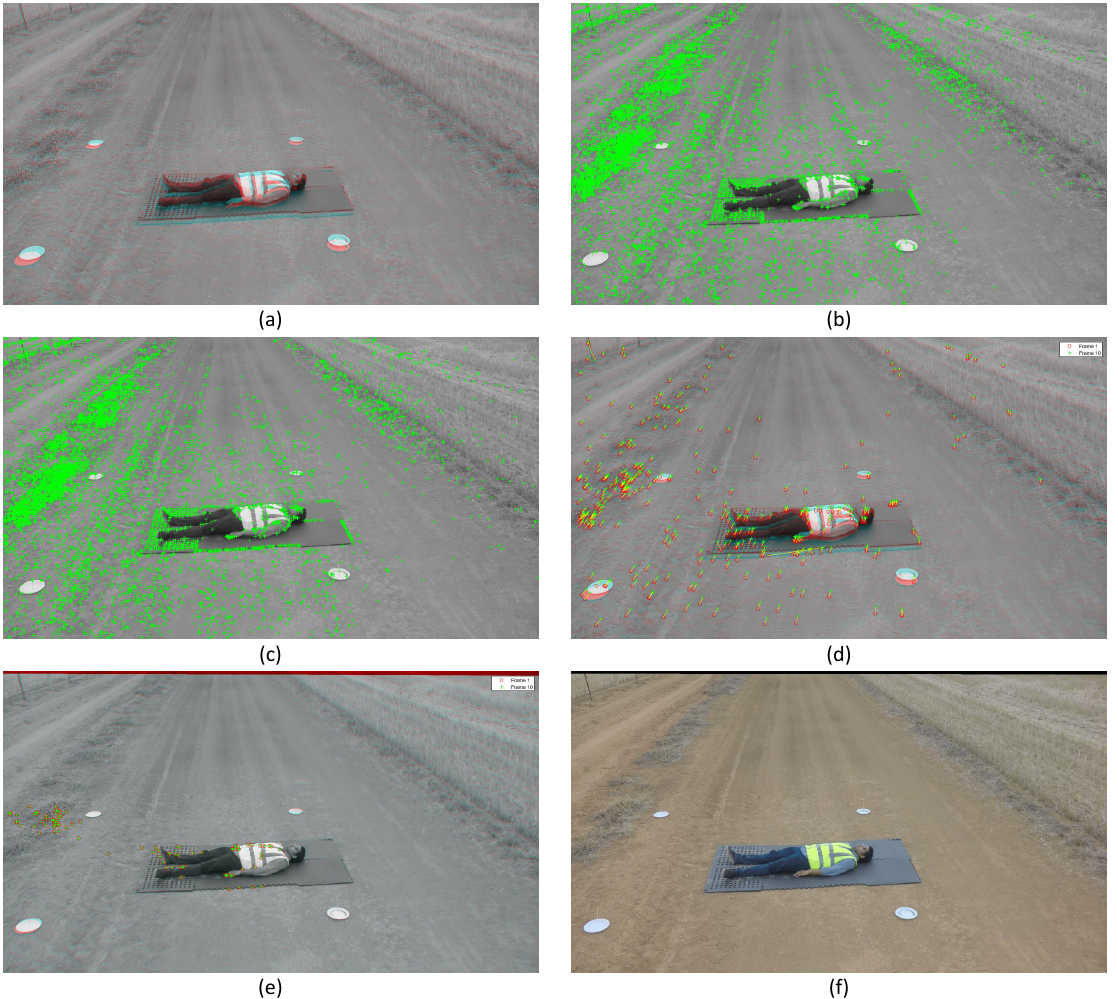
Figure 2. Video stabilization steps of the raw video. Stabilization between the image frame 1 and 10 are illustrated here for the demonstration purpose as they have a noticeable offset. However, in the experiments, adjacent images are stabilized. ( a ) Both images are overlaid to show the offset in the frames in red and cyan colors; ( b , c ) are the first and tenth frames of the video respectively with their detected key points; ( d ) The matching points between the two images are shown in red and green markers; ( e ) Outlier points are removed and only inlier points are used for the similarity transform; ( f ) The stabilized